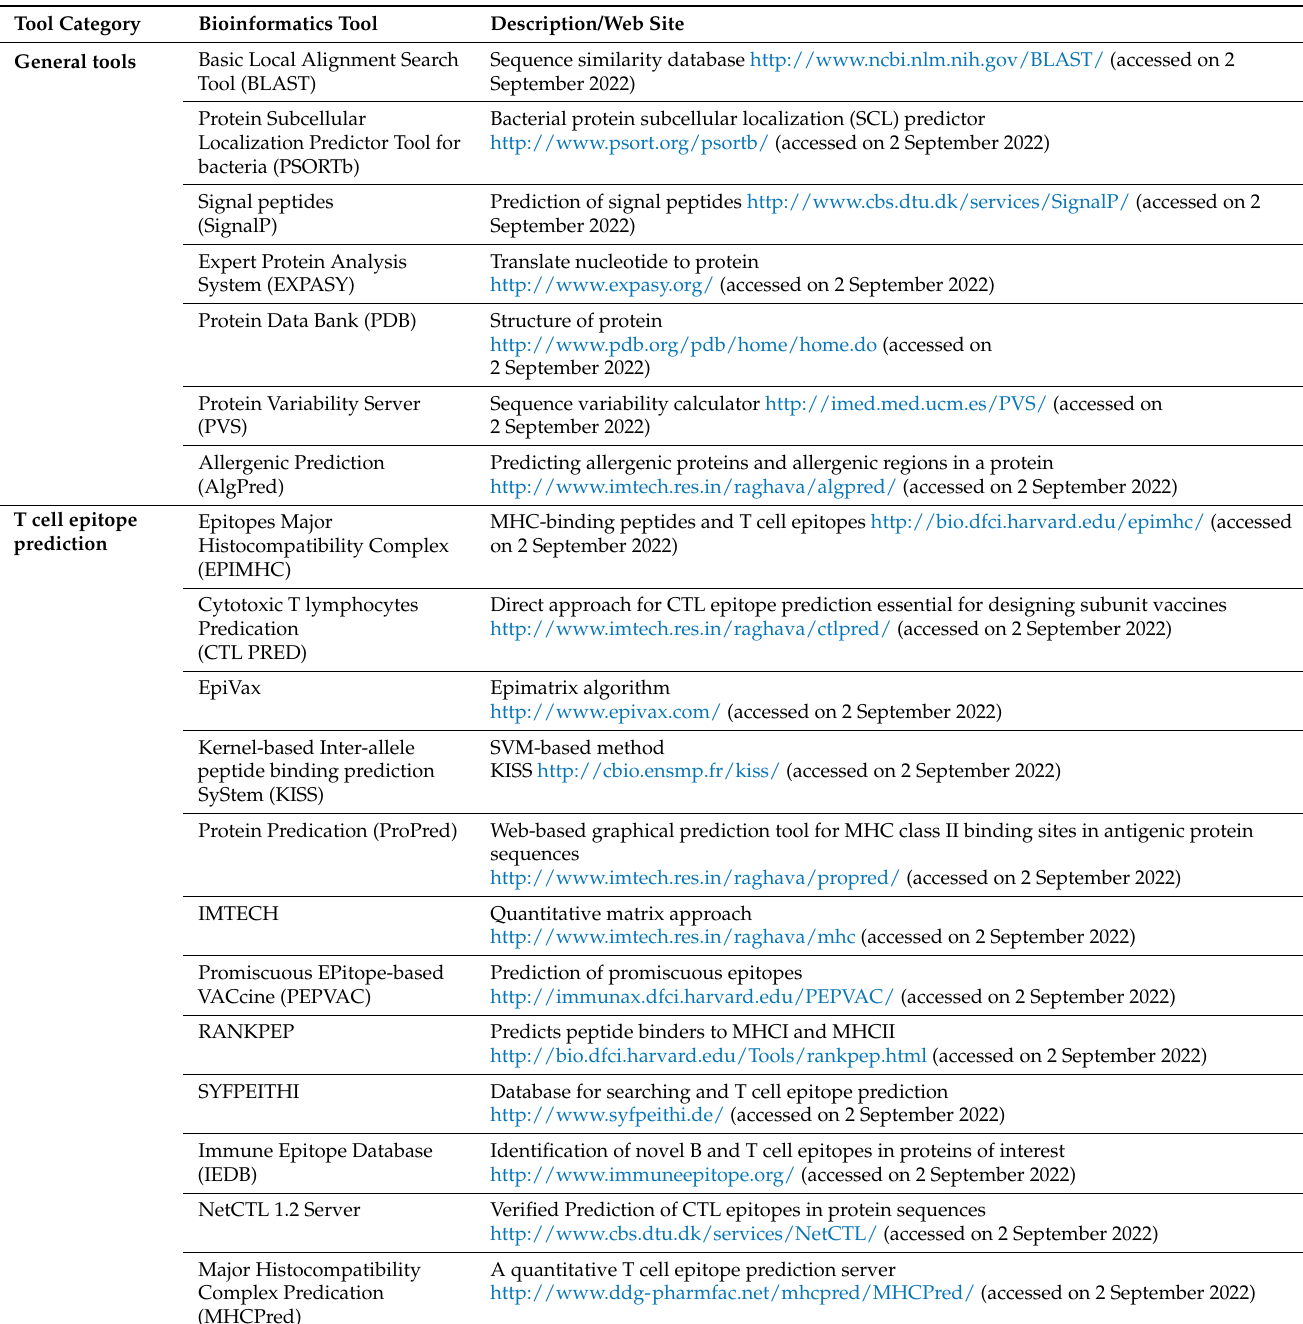
Table 3. Bioinformatics tools available for data mining and vaccine candidate prediction. This information was collected from various sources